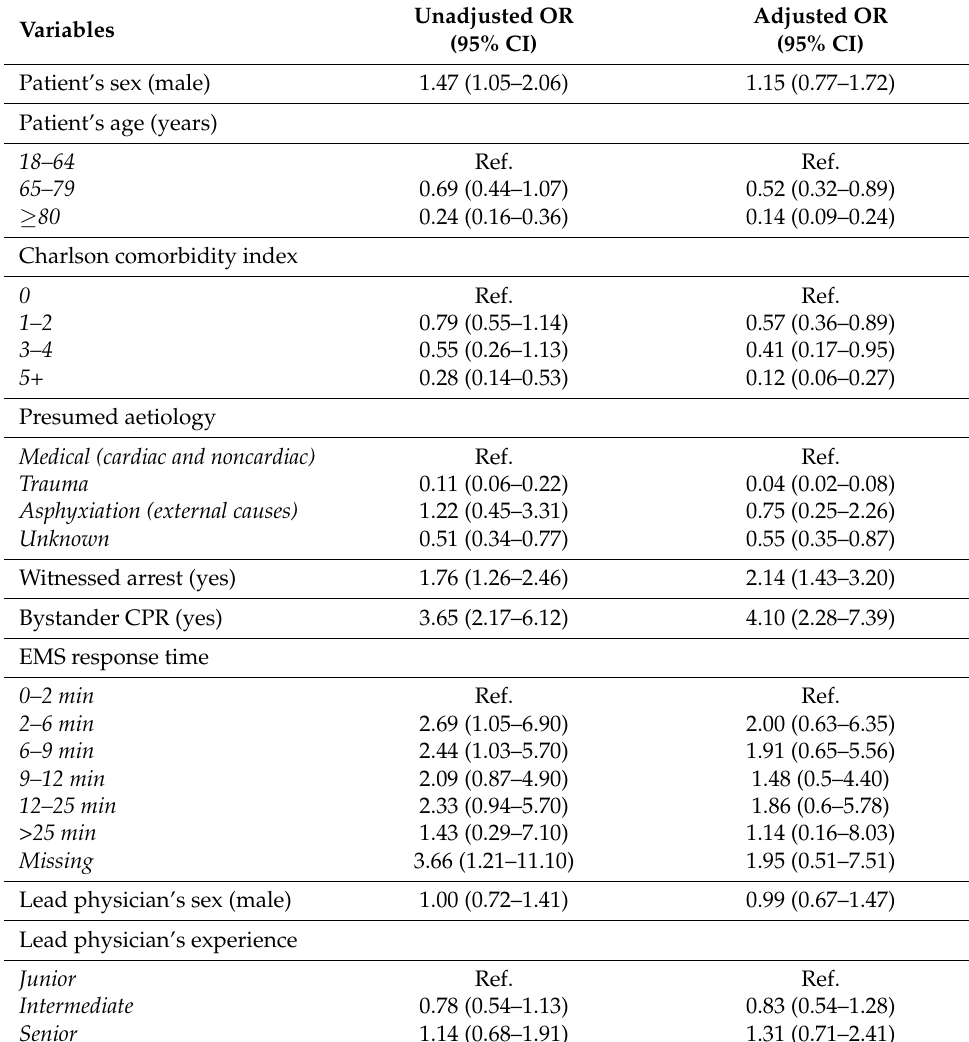
Table 2. Univariable and multivariable logistic